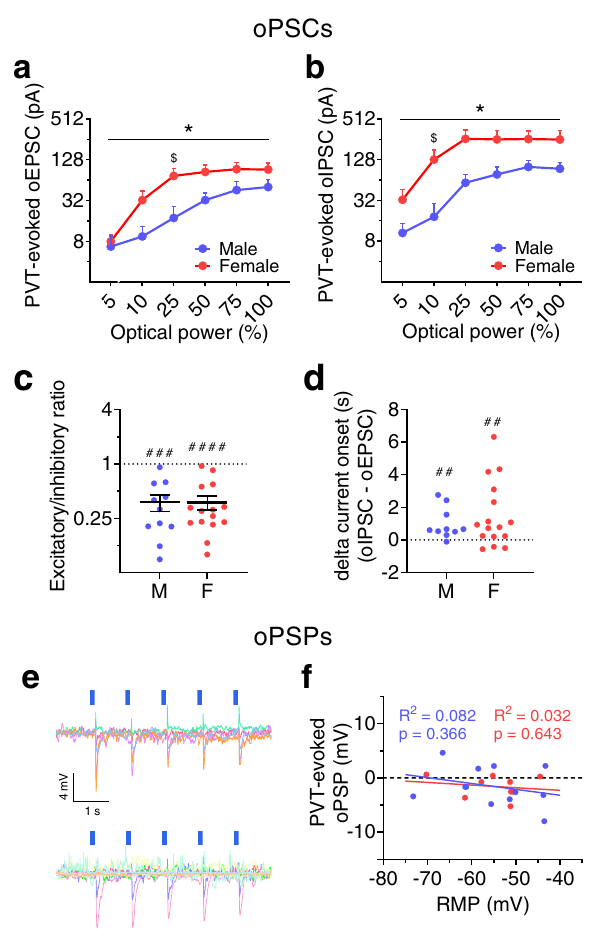
Fig. 4 The PVT provides net inhibition onto BNST CRF neurons. a – b LED power-response curves for optically-evoked EPSCs (oEPSCs, a ) and IPSCs (oIPSCs, b ) in the same BNST CRF neurons (N ’ s = 2 M, 6 cells; 6 F, 13 cells). Data are presented as mean values + SEM. a 2xRM-ANOVA for oEPSCs: power ( F 5,85 = 48.74, P < 0.0001, not indicated), sex ( P = 0.149), sex × power interaction ( F 5,85 = 2.58, * P = 0.032). Post hoc two-tailed t - tests with Holm-Sidak corrections reveal a signi fi cant difference between males and females for 25% power ( t 102 = 2.76, $ P = 0.041) but no other LED powers ( P s > 0.55). b , 2xRM-ANOVA for oIPSCs : power ( F 5,85 = 54.09, P < 0.0001, not indicated), sex ( P = 0.082), a sex × power interaction ( F 5,85 = 2.89, * P = 0.019), but no main effect of sex ( P > 0.05). Post hoc two-tailed t -tests with Holm-Sidak corrections reveal a sex difference for 10% power ( t 102 = 2.94, $ P = 0.024) but no other LED powers ( P s > 0 . 10). c oEPSC/oIPSC ratios in individual BNST CRF neurons showing net synaptic inhibition (one-sample t -tests compared to 1: males: t 10 = 5.50, ### P = 0.0001; females: t 14 = 7.20, #### P < 0.0001) with no sex difference (two-tailed unpaired t -test: t 24 = 0.11, P = 0.912). Data are presented as means ± SEM . d , Difference in the onset time of oIPSCs and oEPSCs (one-sample t - tests compared to 0: males: t 9 = 3.32, ## P = 0.009; females: t 15 = 3.01, ## P = 0.009), with no sex difference (two-tailed unpaired t -test: t 24 = 0.76, P = 0.455). For c – d , N ’ s = 5 M, 11 cells; 8 F, 16 cells. e – f Optically-evoked postsynaptic potentials (oPSPs) in BNST CRF neurons from ChR2 + PVT terminals. e Overlaid oPSP traces from basally inactive BNST CRF neurons, with upward de fl ections indicating time-locked depolarizations and downward de fl ections indicating hyperpolarizations (males, top; females, bottom). f oPSP magnitude plotted as a function of resting membrane potential (RMP). Linear regression equations: males: Y = − 0.109*X – 7.53; females: Y = − 0.049*X – 4.23. N ’ s = 7 M, 12 cells; 6